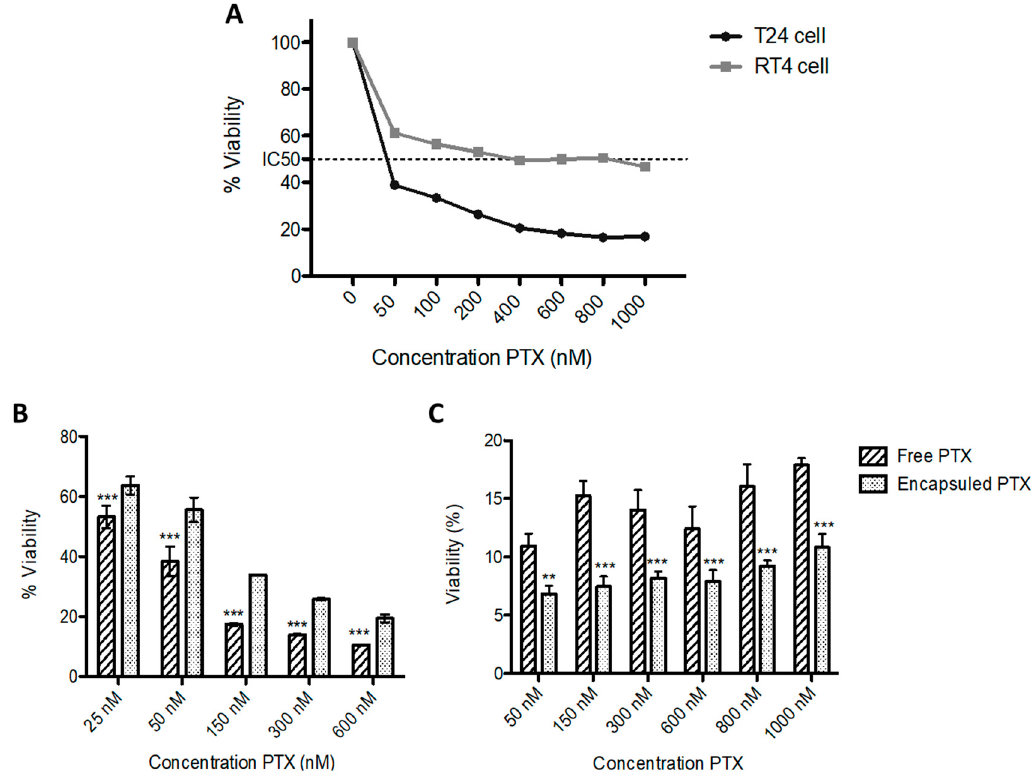
Figure 7. Antitumor efficacy of PTX-NPs. MTT results of cell viability, after being incubated, to increasing concentrations of: ( A )—Naked PTX, for 3 days; ( B , C )—naked PTX and PTX-NPs: ( B )—T24 cells, 3 days incubation; ( C )—RT4 cells, 6 days incubation. Dash line represents 50% viability. Statistics between equal doses of naked vs. encapsulated PTX. ** p < 0.01, *** p < 0.001.